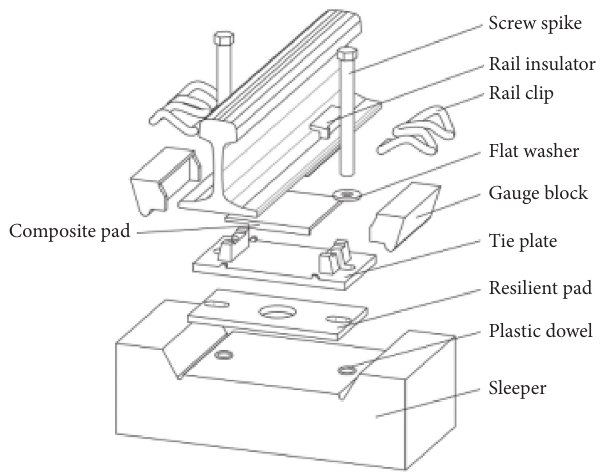
Figure 1: Components of the WJ-8 fastener